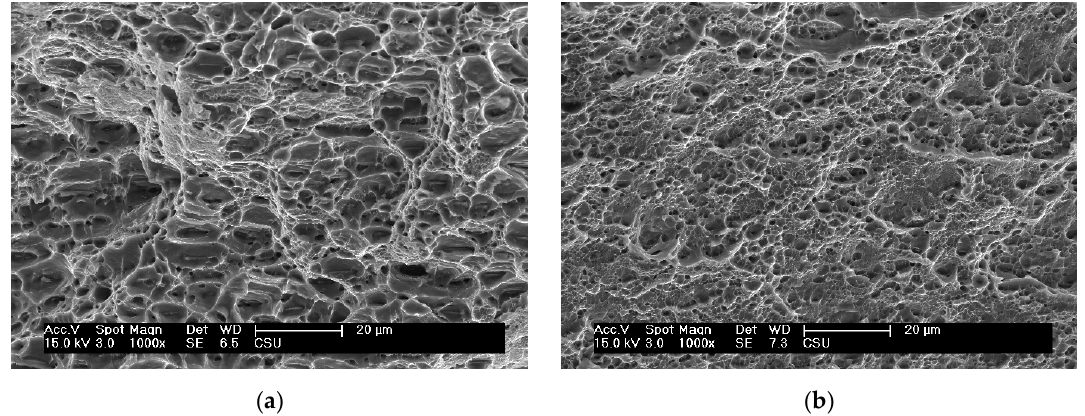
Figure 6. The fracture morphology of the base metal ( a ) and FSW welded joint obtained ( b ) by SEM.